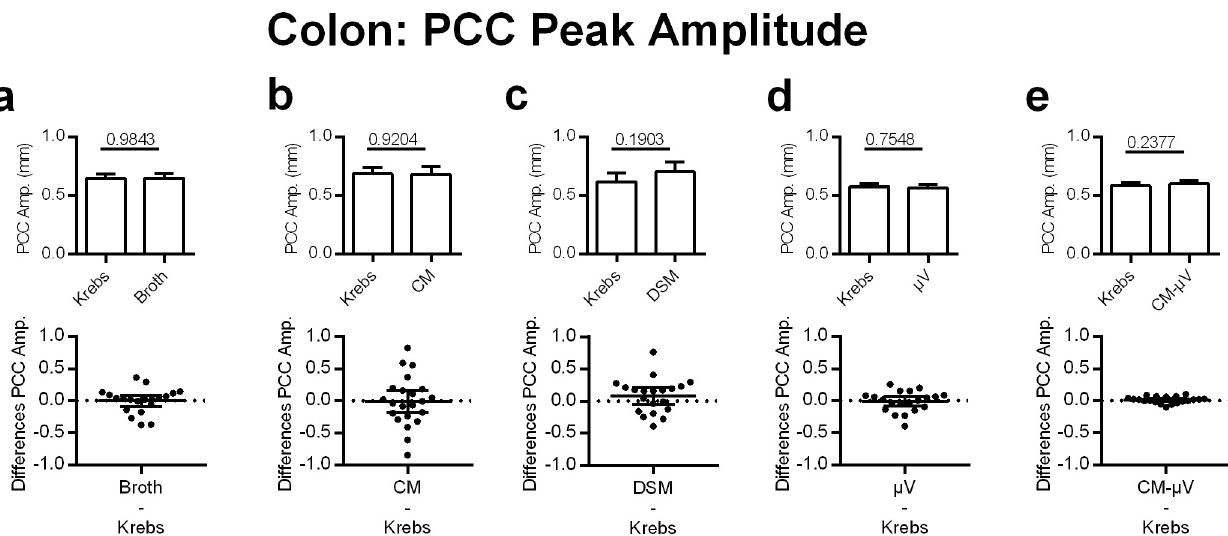
Fig 7. Effects of adding DSM, μ V or media on PCC peak amplitude for mouse colon segments, in vitro . Neither a) broth (N = 20), b) CM (N = 28), c ) DSM (N = 20), d) μ V (N = 20) nor e) CM- μ V (N = 20) had statistically significant effects on PCC peak amplitude. P values derived from paired t-tests are given above horizontal bars. Significance determined when p <